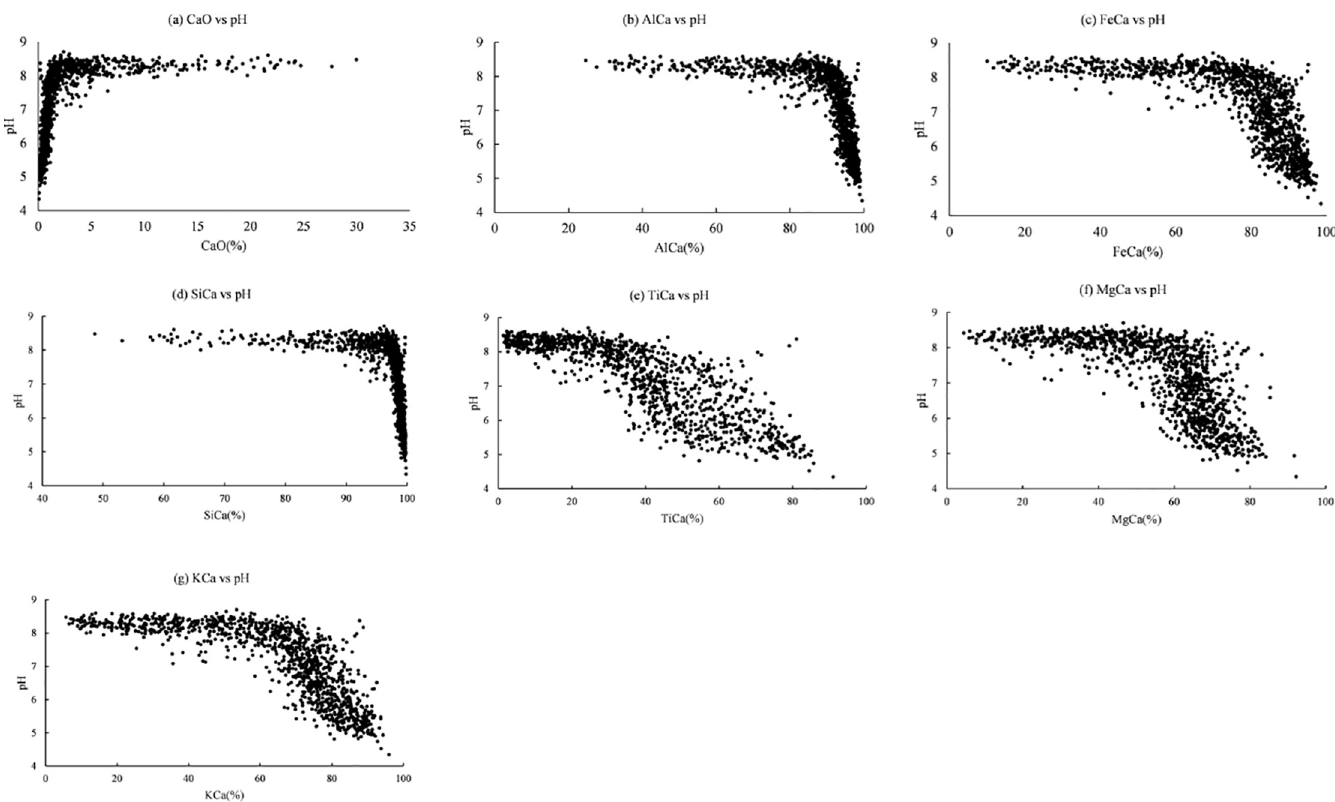
Fig 5. Root mean square error (RMSE) and coefficient of determination (R2) for ANNs with different numbers of hidden nodes (The black box indicates the lowest value of RMSE or highest value of R 2 ).